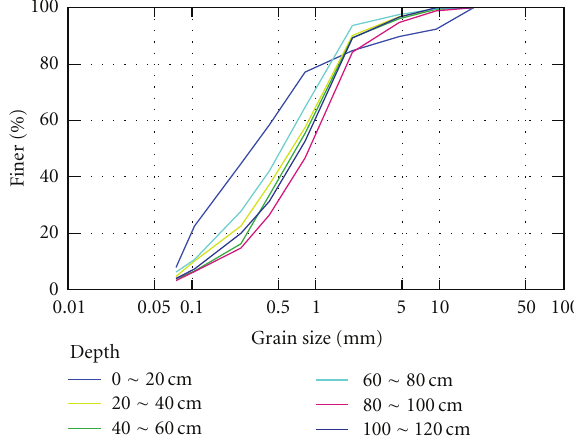
Figure 4: Distributions of grain size of soil